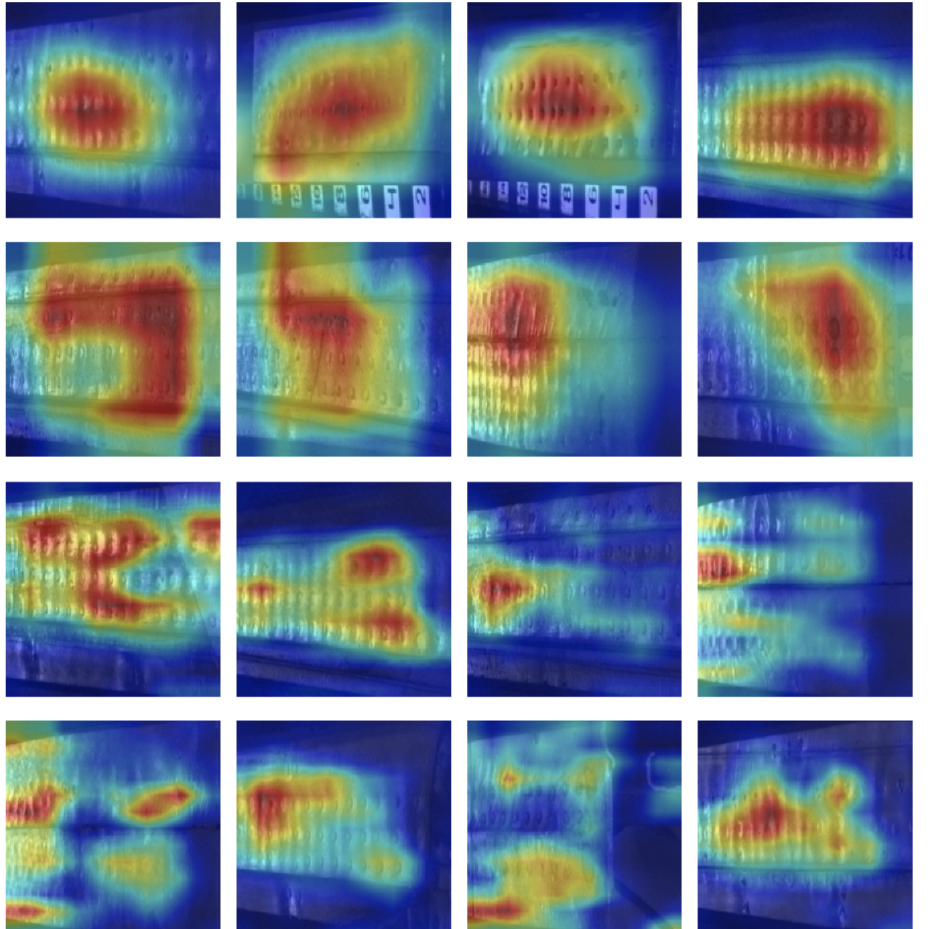
Figure 9. Visualization results through class-activated maps overlaid on input true positive images together with the raw images. The maps were extracted from the last convolution layer using the algorithm GradCam for DenseNet-201 (first two rows) and SqueezeNet (last two rows). The heat maps stand for the larger heights learned during the